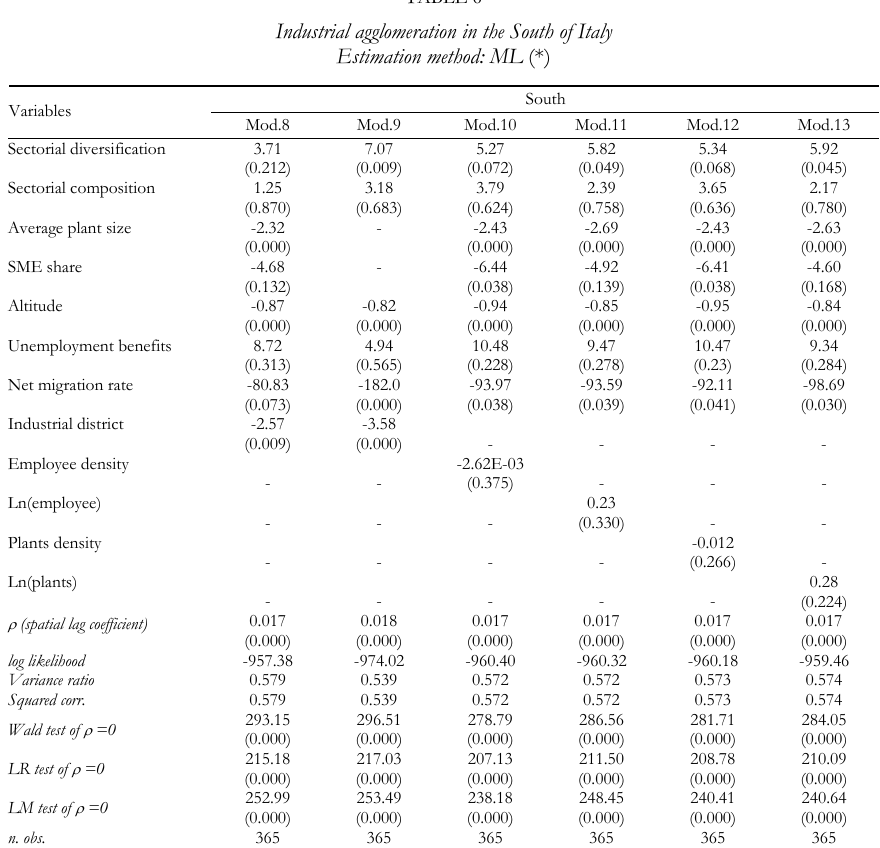
Industrial agglomeration in the South of